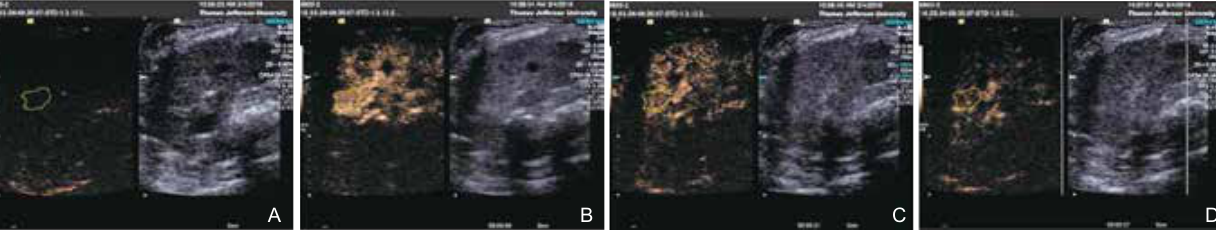
A B C Figure 5 Figure showing the effect of UTMD on tumor vascularity usind contrast-enhaced ultrasound. (A) at baseline before contrast administration (B) after maximum contrast arrival but before UTMD destruction (9 sec) (C) after 1 destructive pulse (21 sec) and (D) after 3 destructive pulses (37 sec). There is an apparent ruduction in tumor vascularity after 3 phases of UTMD in the tumor region. (Reprinted with permission from reference [46])